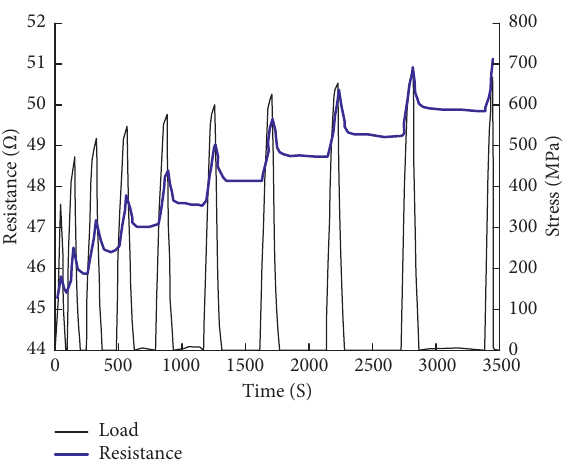
Figure 10: Curve of resistance and tensile stress of the carbon nanotube yarn.